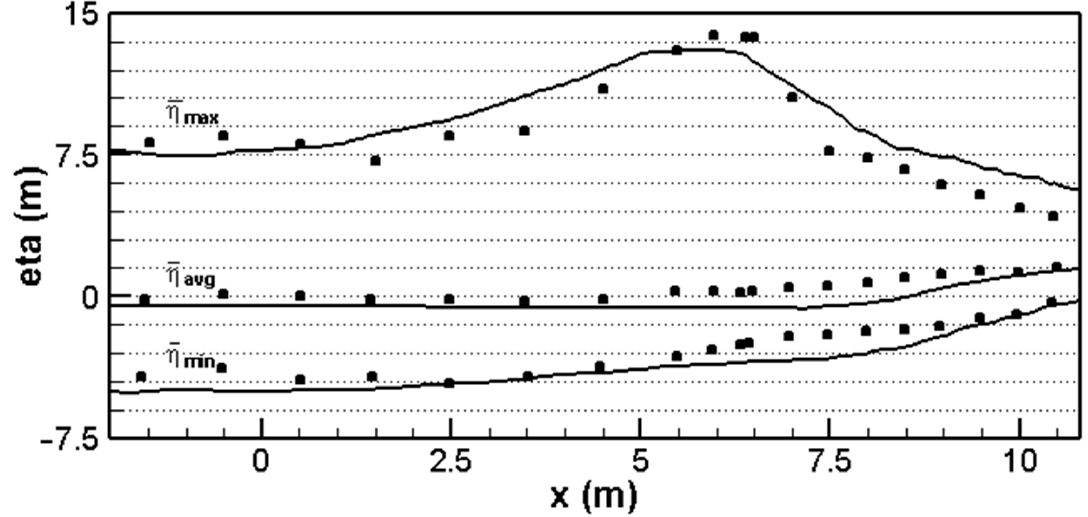
Figure 8. Results 4: minimum, average and maximum water surface elevations in Configuration WKC, showing numerical results (solid line) and experimental measurements (circles) [3].